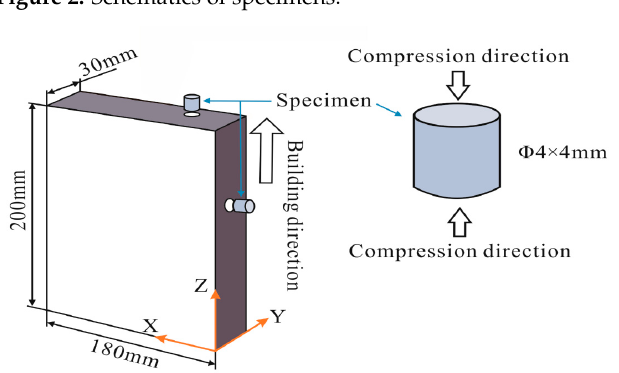
Figure 2. Schematics of specimens.